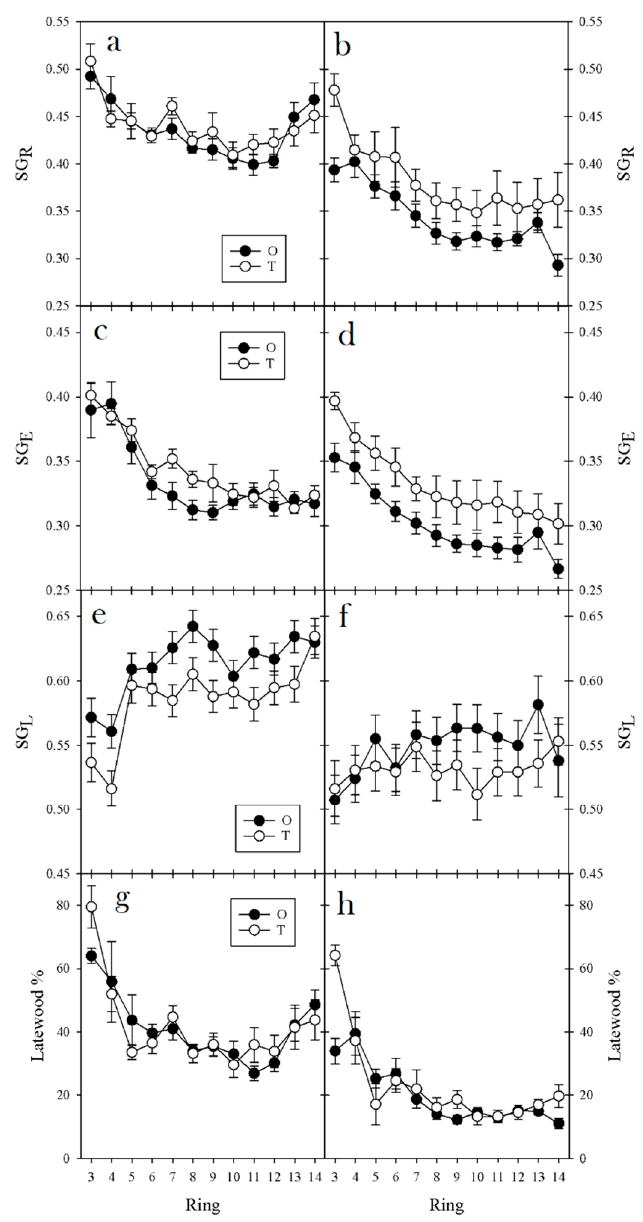
Figure 4. Ring specific gravity ( a , b ); earlywood specific gravity ( c , d ); latewood specific gravity ( e , f ); and latewood percentage ( g , h ) for: Douglas-fir ( a , c , e , g ); and western redcedar ( b , d , f , h ) trees growing under contrasting vegetation management treatments on a site located in the Cascade Foothills of western Oregon. O: no post-planting vegetation control (open symbol); T: sustained vegetation control during first five years post planting (filled symbol). Error bars represent standard error.